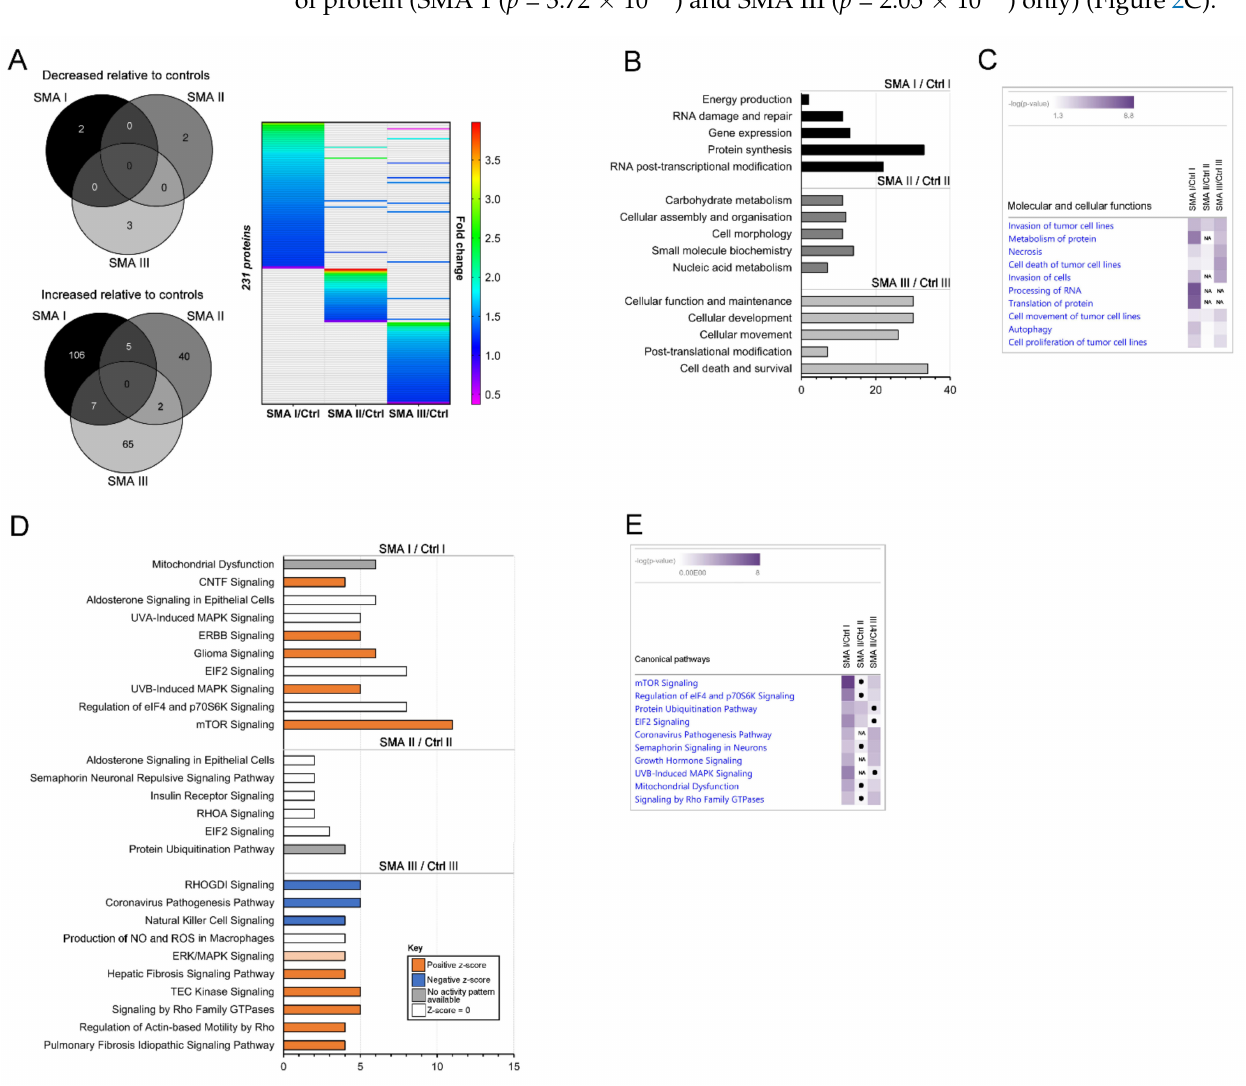
Figure 2. Summary and bioinformatics analysis of proteomic profiles of SMA Types I, II and III fibroblasts relative to their age-matched controls. ( A ) Venn diagrams illustrating the lack of overlap between significantly downregulated and upregulated proteins in each SMA type and heat map detailing the extent of the fold changes relative to age-matched controls. ( B ) Bar charts showing the top five significantly enriched molecular and cellular functions relating to the differentially expressed proteins in each SMA type following Ingenuity Pathway Analysis (IPA ® ). The x -axis relates to the number of dysregulated proteins associated with each function. ( C ) A three-way comparison generated in IPA ® in which the enriched cellular and molecular functions are ranked by − log( p -value) for each SMA type. “NA” denotes terms for which no differentially expressed proteins were associated within the specified dataset. ( D ) Bar charts showing the top ten significantly enriched canonical pathways for the SMA Type I and III fibroblasts (also ranked by number of molecules) and the enriched canonical pathways for SMA Type II fibroblasts after excluding terms matched with only one molecule. The x -axis relates to the number of dysregulated proteins associated with each function. ( E ) A three-way comparison generated in IPA ® in which the enriched canonical pathways are ranked by − log( p -value) for each SMA type. Black dots denote terms that were not enriched with statistical significance (i.e., p ≥ 0.05) but that had at least one differentially expressed protein associated with it, and “NA” denotes terms for which no differentially expressed proteins were associated within the specified